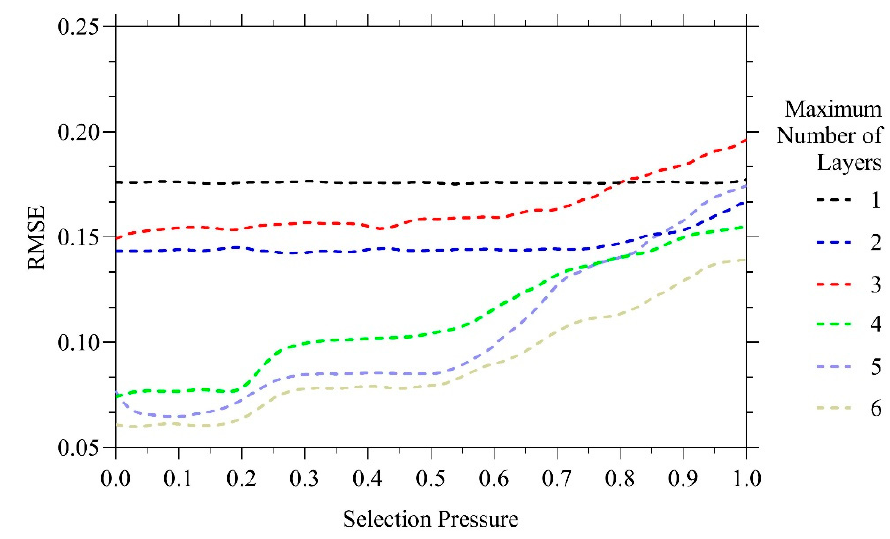
Figure 9. GMDH: dependence of the RMSE at the end of training on the maximum number of layers in the ANN, and on the value of the selection pressure.